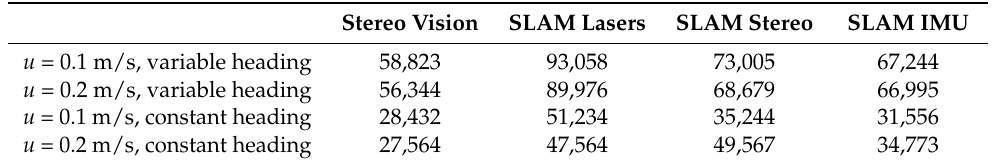
Table 2. Integral of absolute error for heading control. Stereo Vision SLAM Lasers SLAM